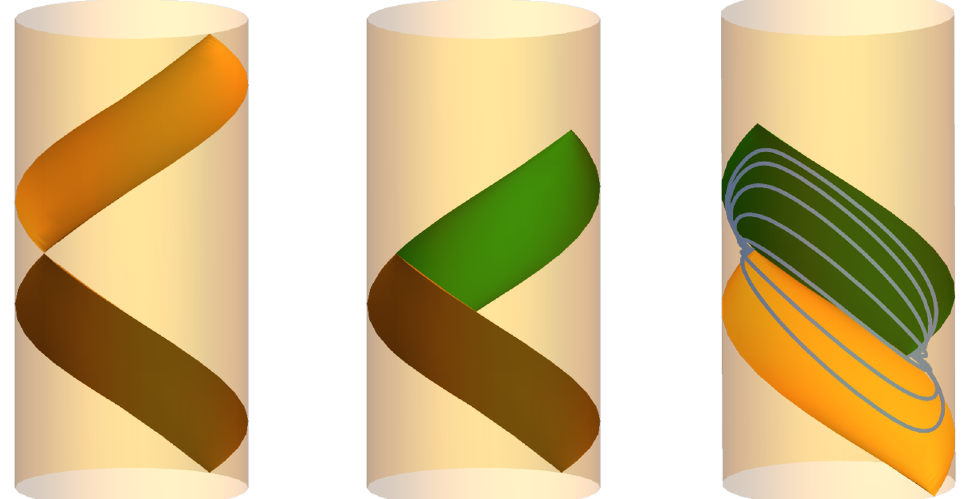
Figure 1 . AdS 3 and its patches, plotted using global coordinates ( (cid:28); (cid:31); (cid:10)) as cylindrical coordinates with height (cid:28) , radius (cid:31) , and angle (cid:10). The maximally extended spacetime has a cylindrical conformal boundary at (cid:31) = (cid:25)= 2, shown here in translucent orange. On the left, we show the Poincar(cid:19)e horizons (cid:28) (cid:6) that bound the Poincar(cid:19)e patch. In the middle, we show (cid:28) (cid:0) along with the future horizon (cid:28) H (which is also a Poincar(cid:19)e horizon); these bound the \extremal patch" that becomes the BTZ exterior after identi(cid:12)cation. Finally, on the right we show the same plot from a di(cid:11)erent perspective, along with a selection of integral curves of the Killing (cid:12)eld (cid:24) = @ X . The extremal BTZ black hole is obtained by identifying discretely along these